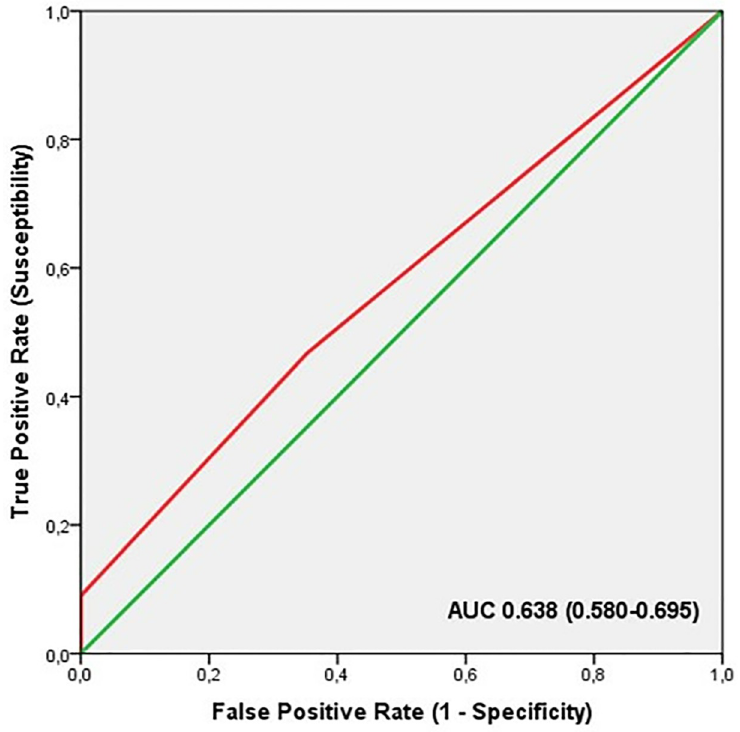
Fig 4. ROC curve summarising the ability of TGS of iron metabolism and energy efficiency genes to distinguish potential professional athletes from non-athletes.